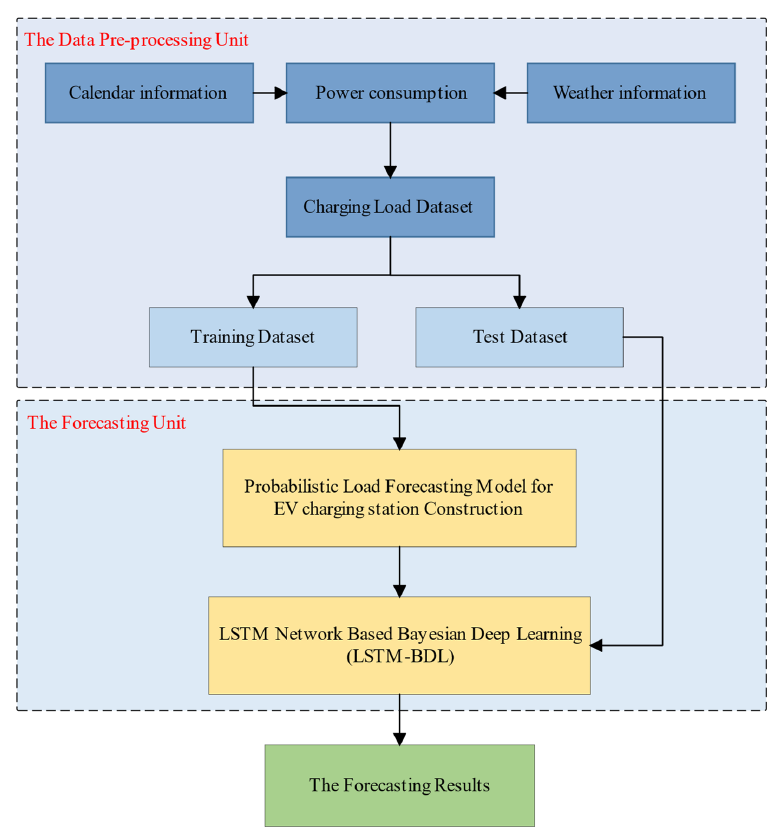
Figure 1. Overall framework of the method.